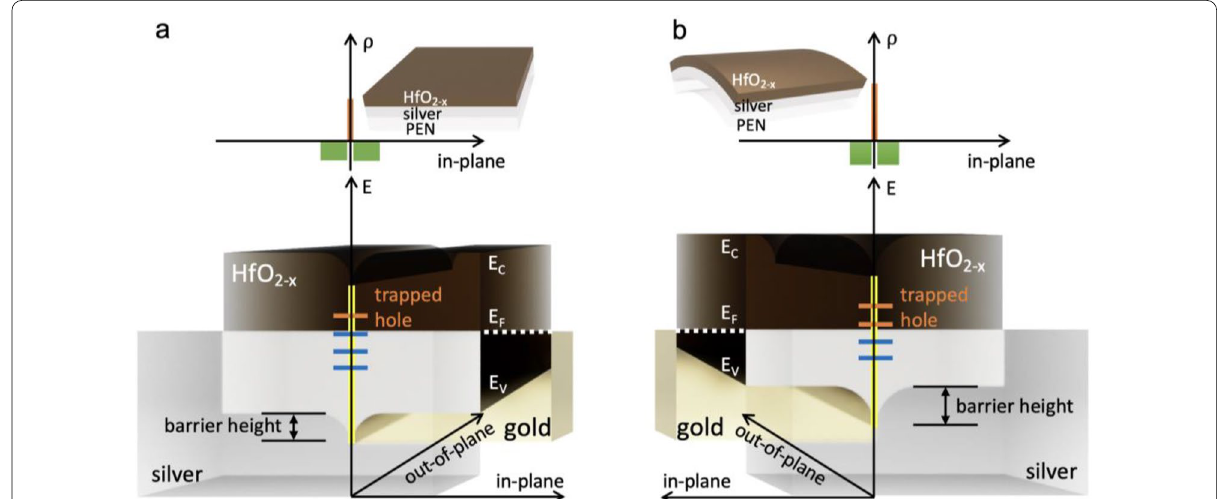
Fig. 7 Band structure differences between a a planar and b a bent HfO 2- x thin film. The space charge distribution (top) represents a thermal equilibrium state between the trapped hole density at the grain boundary (orange) and the negatively charged acceptor density (green) in a cross section across grain boundaries in the in-plane direction. The insets in a and b show a planar and a bent HfO 2- x thin film, respectively. In the three-dimensionally expressed band diagrams (bottom), grain boundaries are marked by yellow lines, and the blue and orange lines on the grain boundaries indicate electron-filled and trapped hole states, respectively. In particular, the contact planes between HfO 2-x and silver of the band diagram are depicted with the color of